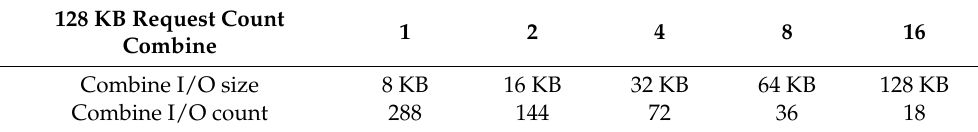
Table 2. Combining process scale for 16 128 KB-sized requests in the 16 + 2 EC